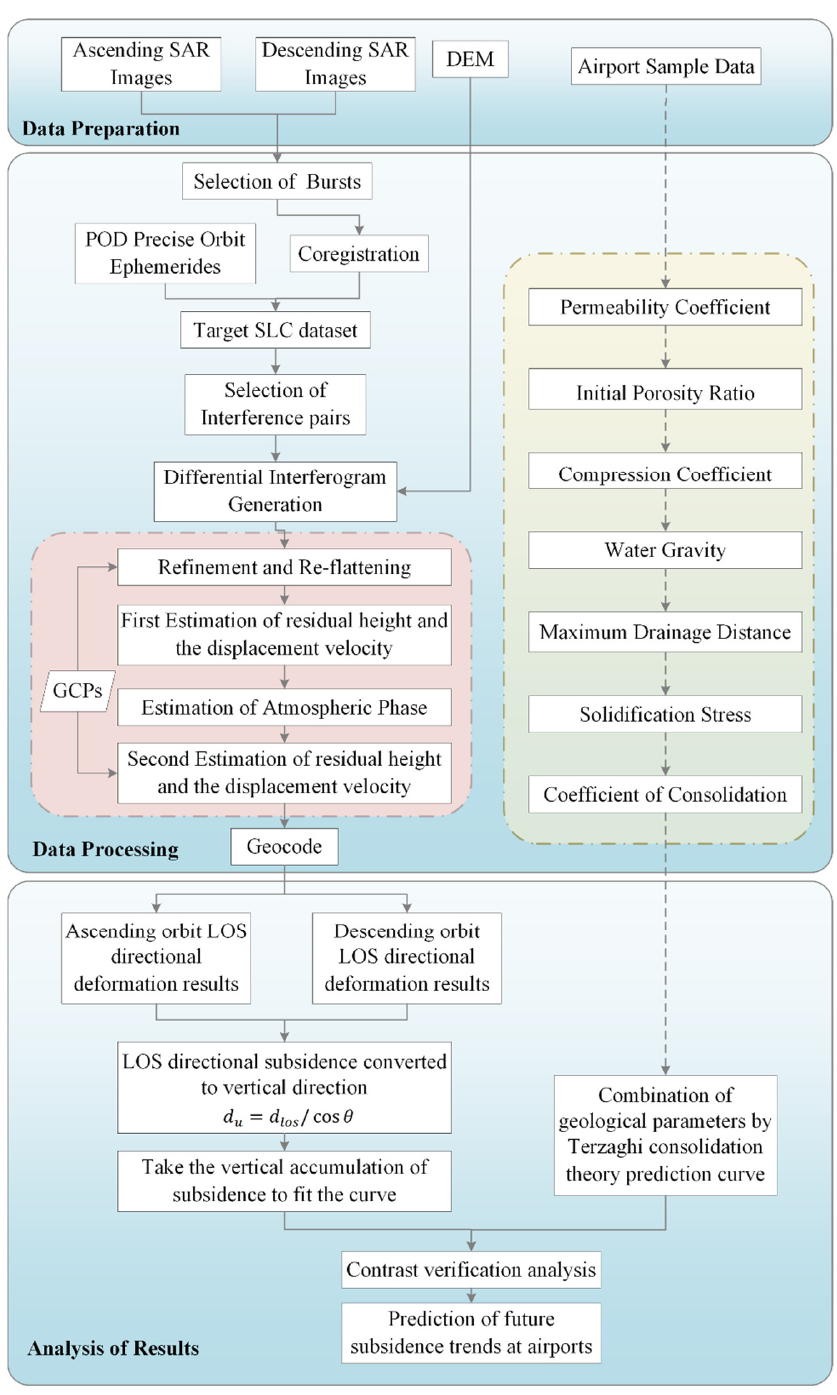
Figure 5. Flowchart of Integration of SBAS-InSAR and Terzaghi consolidation theory.